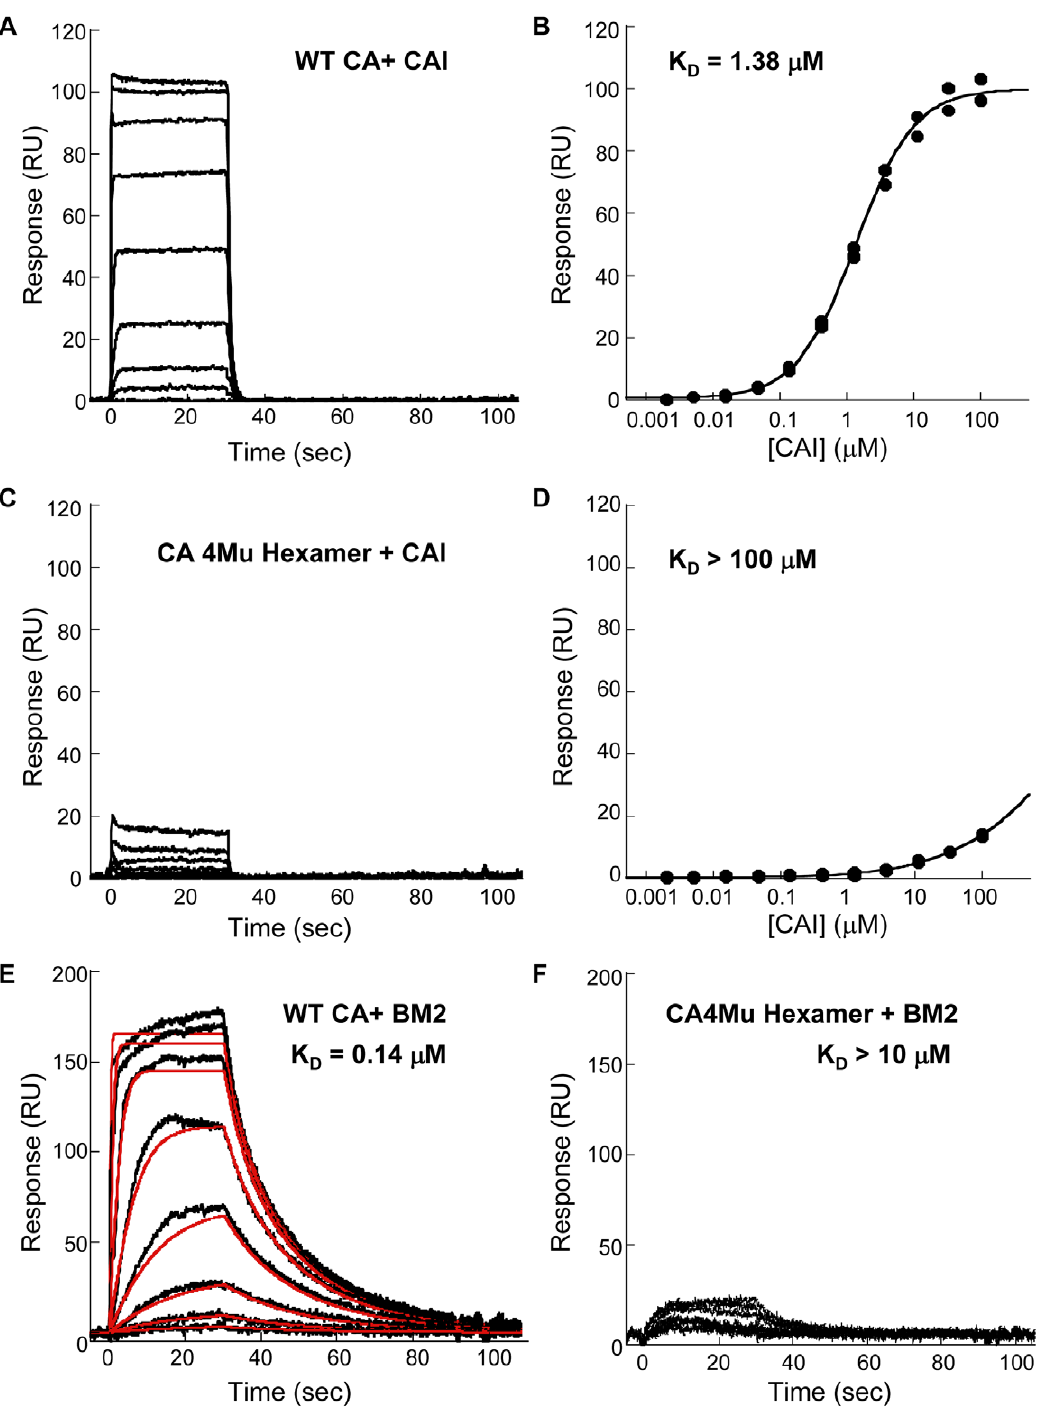
Figure 6. Binding of CAI peptide and BM2 to WT CA and CA 4Mu Hexamer analyzed by Surface Plasmon Resonance. ( A ) Sensorgram data of CAI binding to WT CA. CAI was injected at the highest concentration of 100 m M and ten 3-fold serial dilutions thereof. Each trace was collected in duplicate. ( B ) Fit of sensorgram data in A by fitting the equilibrium response at each concentration to a simple 1:1 binding isotherm model. ( C ) Sensorgram data of CAI binding to hexamer. CAI concentrations used were the same as in A. ( D ) Attempt to fit sensorgram data in C to a simple 1:1 binding isotherm model. Due to insufficient response, an accurate equilibrium dissociation constant for this interaction could not be obtained. The K D for this interaction was simply cited as . 100 m M. ( E ) Sensorgram data for the binding of BM2 to WT CA (black curve, sensorgram: red curve kinetic analysis using a simple 1:1 kinetic binding model). The K D for this interaction was calculated from the ratio of the k on and k off rate constants obtained from this fit. ( F ) Sensorgram data for the binding of BM2 to CA 4Mu Hexamer. The affinity of BM2 to hexamer is too weak to allow for quantification of the k on and k off rate constants.